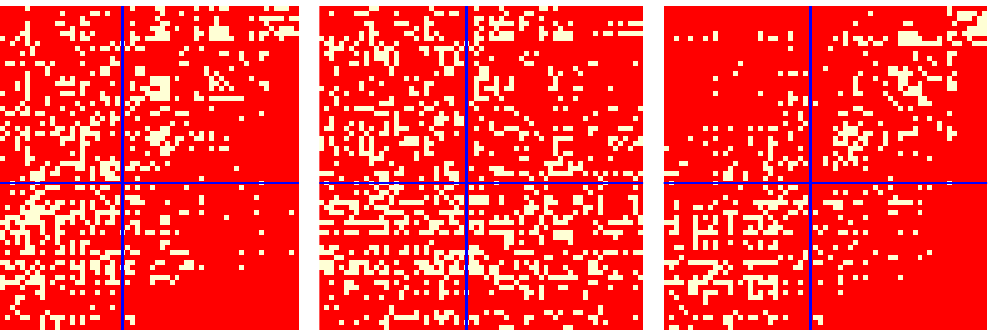
( e ) Cowork network, partitioned by ( f ) Friendship network, partitioned by the predicted labels by PAF the predicted labels by PAF Figure 4. Heatmap plots of the adjacent matrices of the three network layers, ordered by the ground truth labels and the predicted labels by PAF, respectively.